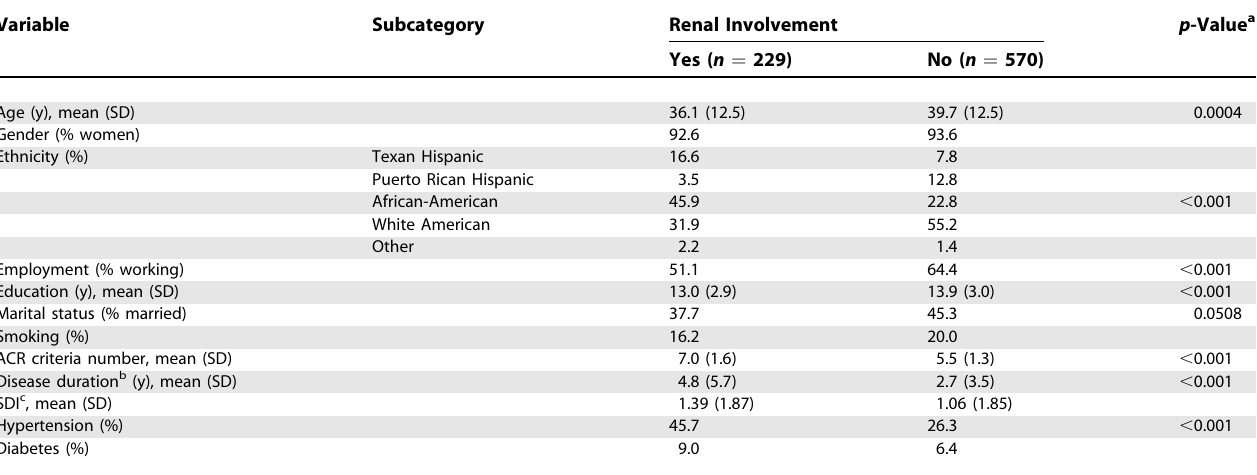
Table 1. Baseline Socioeconomic–Demographic and Clinical Features of PROFILE Patients as a Function of Renal Involvement (Incident